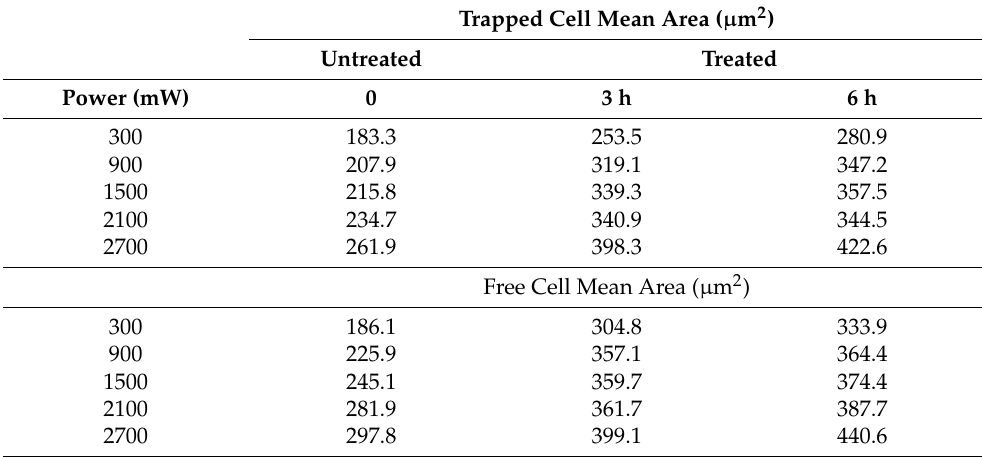
Table 2. The values of the essential statistical parameters of the area of the untreated and treated A549 lung cells with a laser trap at 300 mW. Trapped Cell Mean Area ( µ m 2 ) Untreated Treated